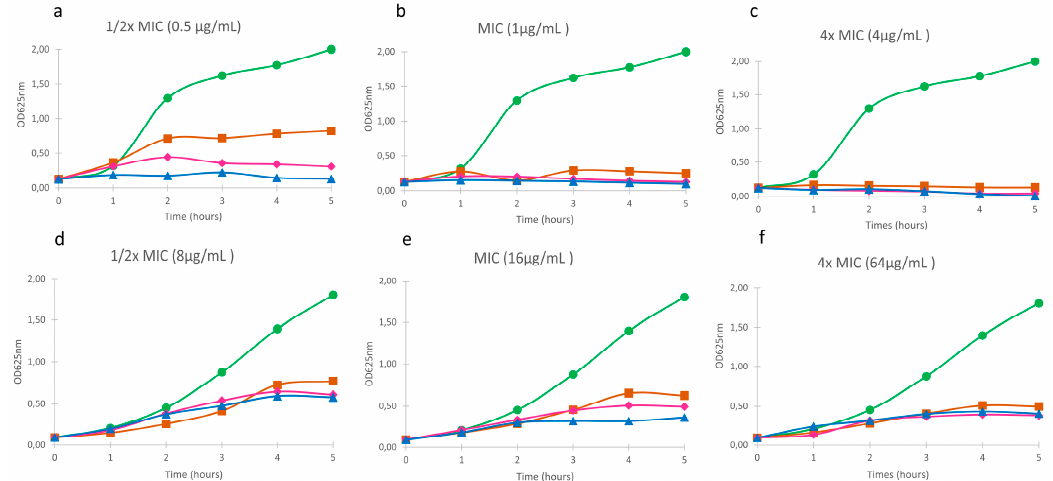
Figure 3. The effect of free and nanoencapsulated (SLN and NLC) tobramycin on the growth of P. aeruginosa. ( a , b , c ) strain 056SJD; ( d , e , f ) strain 362VH. Control ( ); Free tobramycin ( ); SLN- Tobramycin ( ); NLC-Tobramycin ( ).